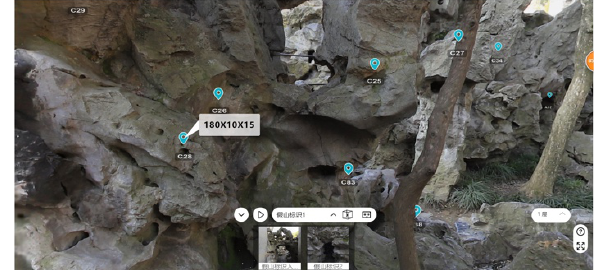
Figure 7. The panoramic photo to show data of cracks.